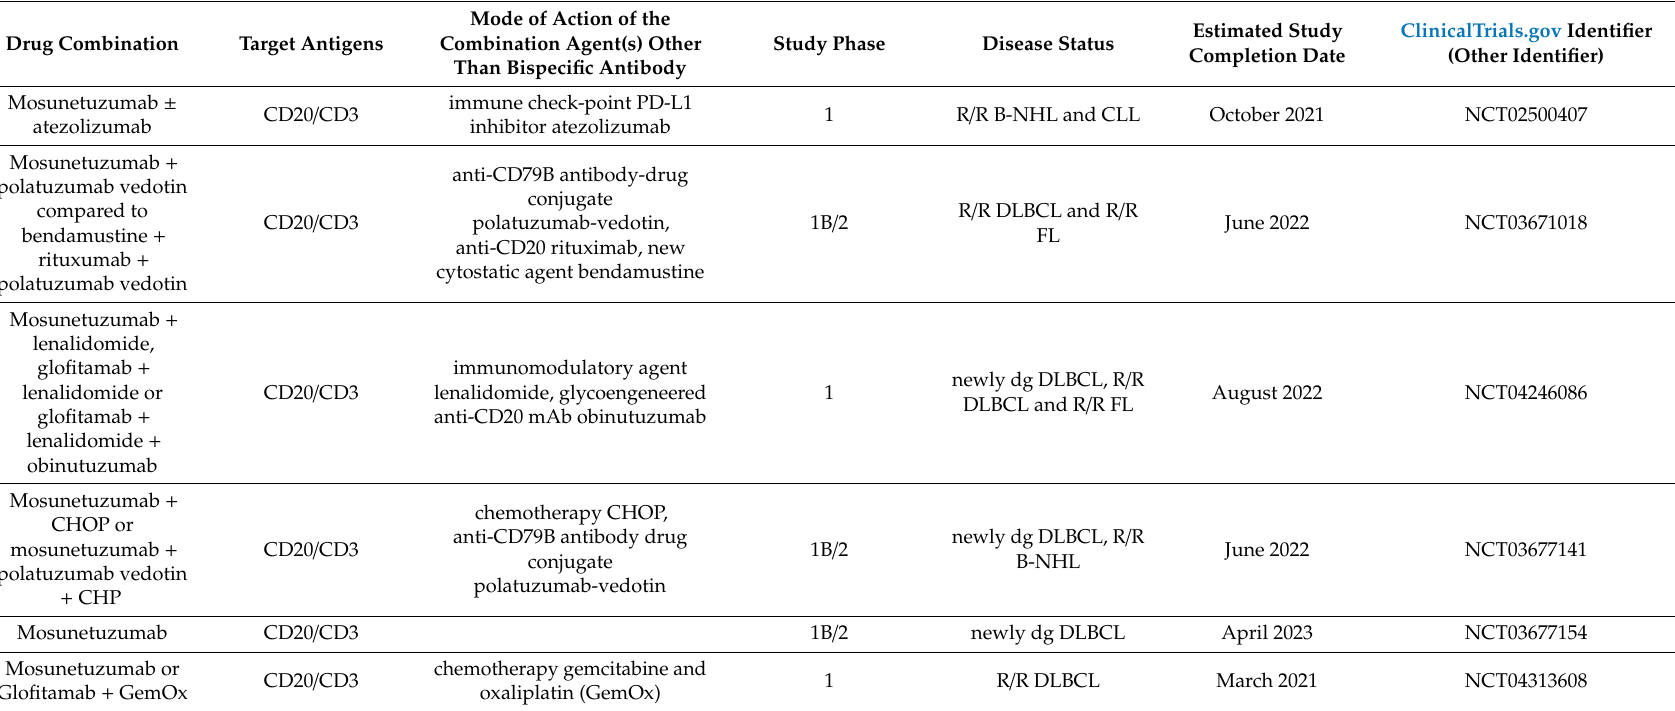
Table 2. Selected clinical trials that incorporate mosunetuzumab in experimental therapy of